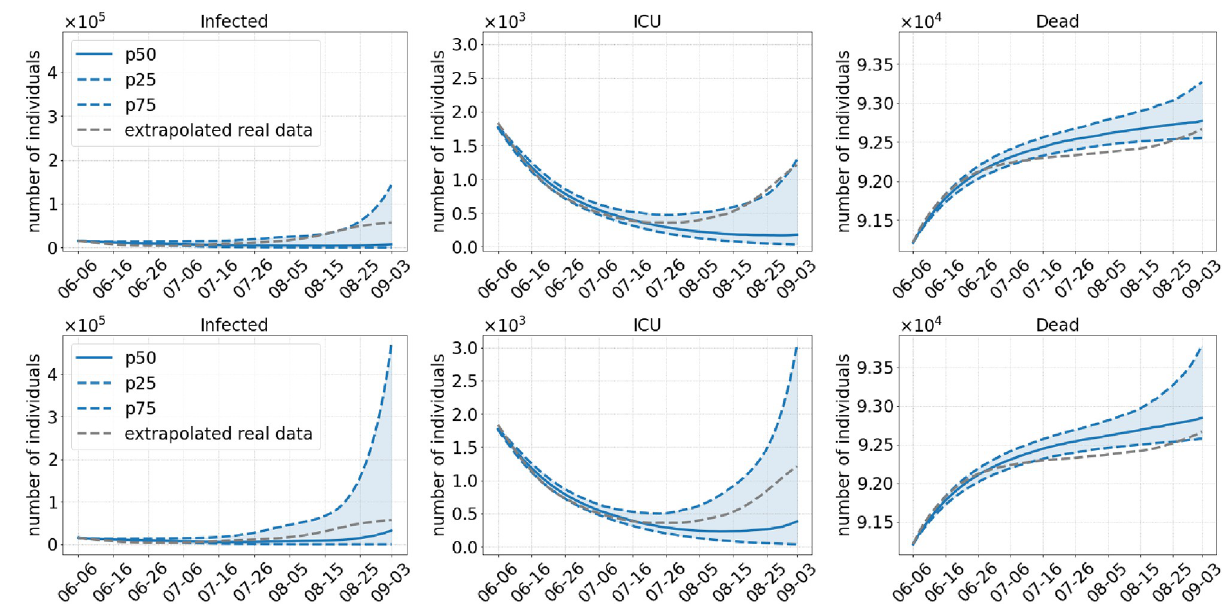
Fig 7. Results of Scenario 3: No commuter testing, local NPIs decreed until August 01, 2021, no masks after opening. The median of 500 runs is shown in solid blue; the blue dotted lines are the 25% and 75% percentiles. The top row shows results with an assumed 40% more transmissible Delta variant compared to 60% in the bottom row.